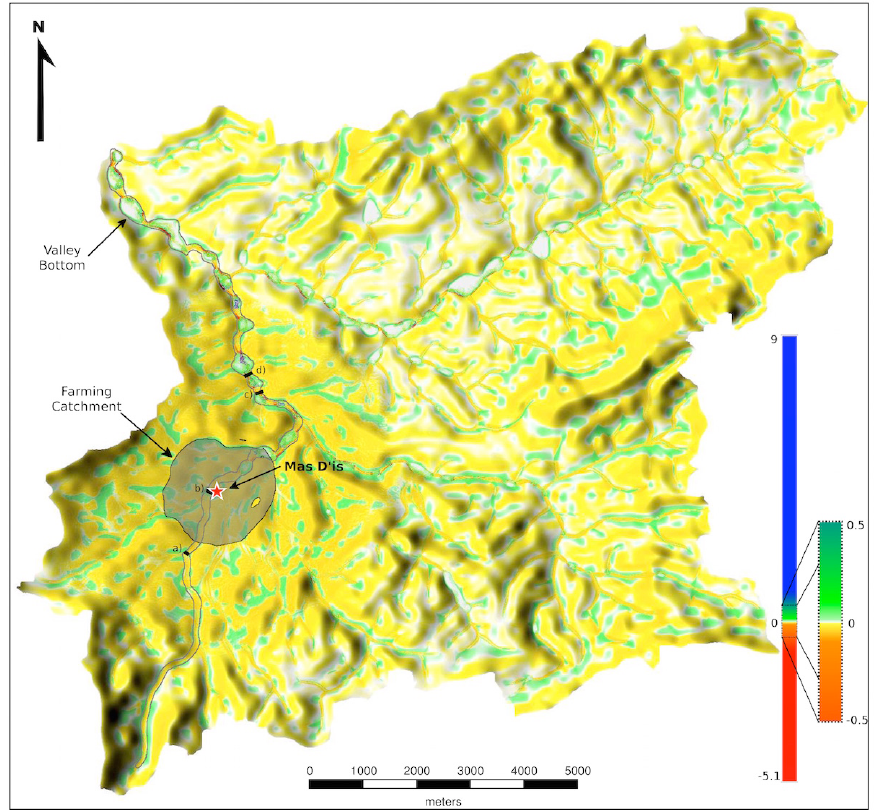
Figure 9. Map of cumulative erosion and deposition after 300 simulated years for one run of the maximizing large population scenario (see Table 1). The farming catchment is shown as a shaded region surrounding the site of Mas d’Is (indicated by the red star). The outline of the main Barranco that passes near Mas d’Is is also shown, as are the locations of the four cross-sections shown in Figure 6. Warm colors (yellow through red) indicate cumulative erosion, and cool colors (green through blue) indicate cumulative deposition. Scale is in